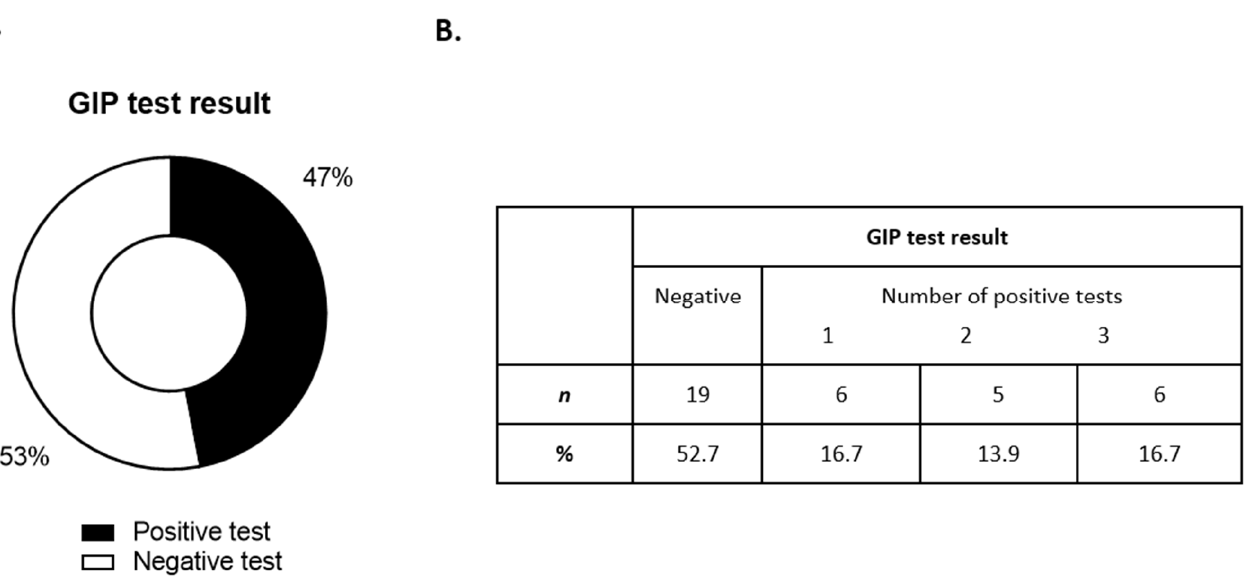
Figure 5. ( A ) Frequency of patients with a positive or negative urine GIP test result. ( B ) Frequencies of number of positive tests.